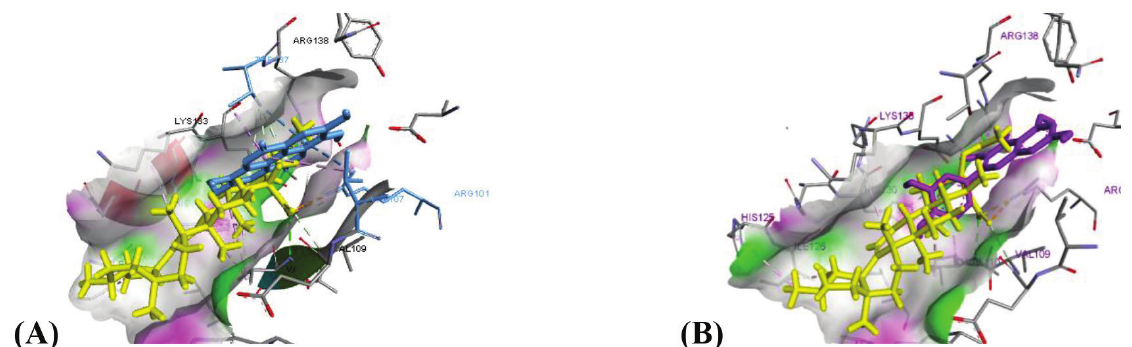
Figure 4. 3D visualization of the native AKBA ligand compatible conformation (yellow molecule) with ( A ) ellagic acid (blue mole- cule) and ( B ) quercetine (purple molecule).